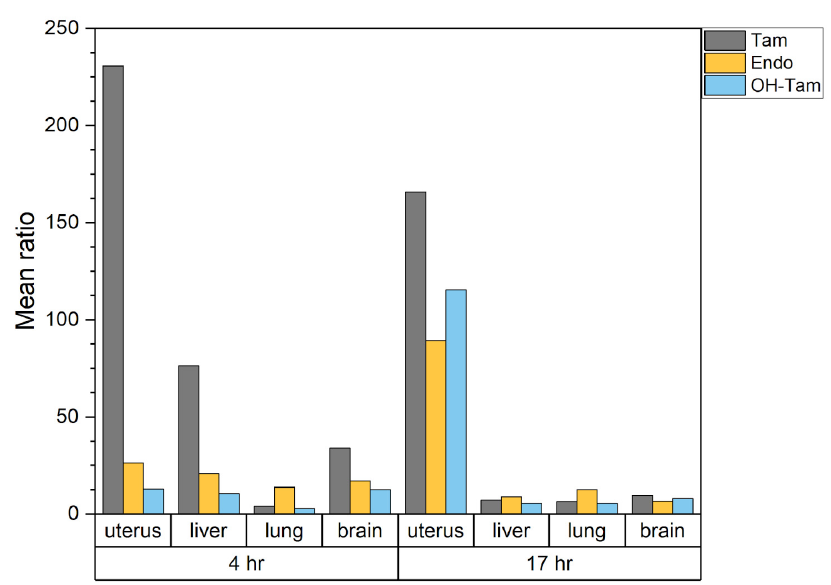
Figure 5. Ratios of mean organ metabolite concentration in injected and fed sample groups repre- sented as columns.